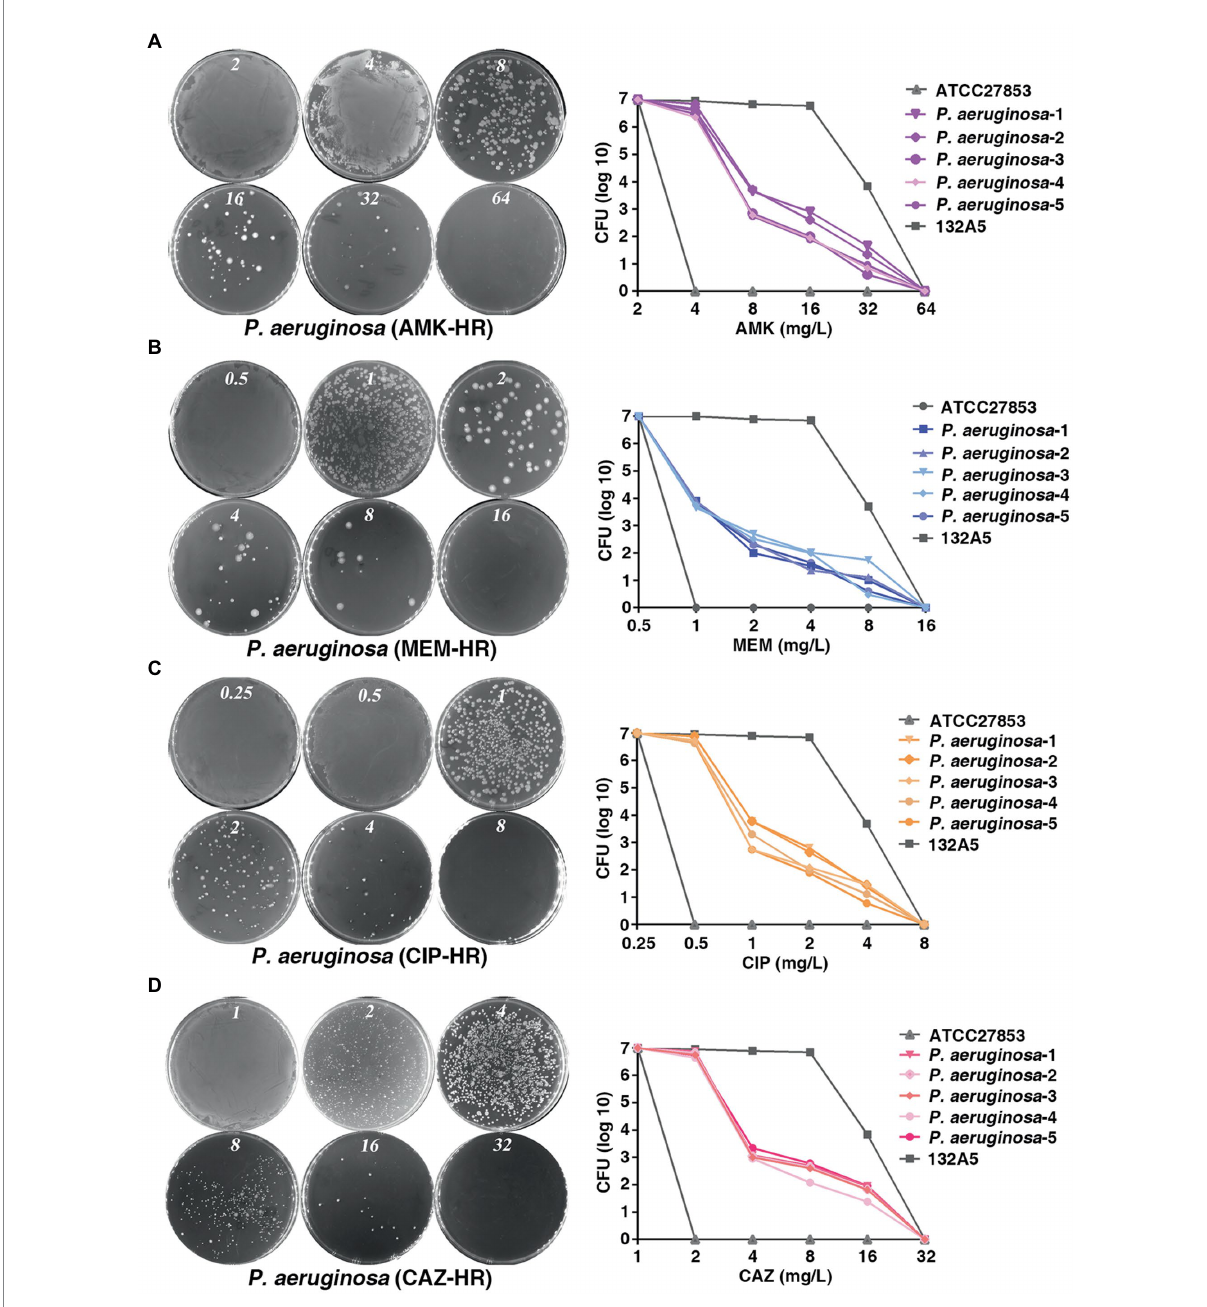
FIGURE 1 Prevalence of heteroresistance in clinical Pseudomonas aeruginosa isolates. (A–D) P. aeruginosa was heteroresistant to AMK, MEM, CIP and CAZ, respectively. PAPs were performed in five clones of P. aeruginosa isolate. Both the sensitive (ATCC 27853) and resistant strains (132A5) of P. aeruginosa were used as control. AMK, amikacin; MEM, meropenem; CIP, ciprofloxacin; CAZ,